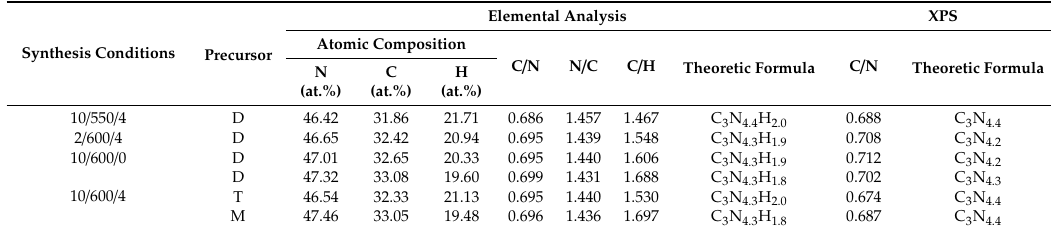
Table 3. Elemental analysis of carbon nitrides obtained under various conditions and elemental composition determined from XPS analysis